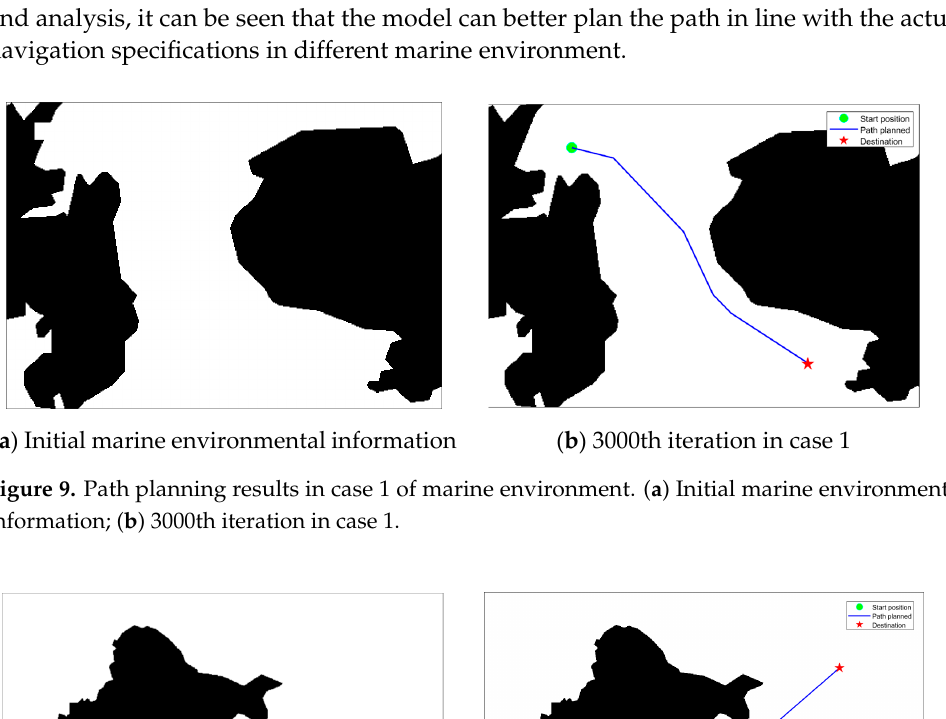
Figure 8. Path planning results under different iterations. ( a ) 500th iteration; ( b ) 1000th iteration; ( c ) 2000th iteration; ( d ) 3000th iteration. In order to verify the credibility and effectiveness of the model, this paper selects other complex marine environment for the experimental verification of ship path plan- ning. Figure 9 shows the path planning results of the model in marine environment case 1. Figure 9a shows the initial environment of marine environment case 1, and Figure 9b shows the path planning results after 3000 iterations. The starting point coordinates of the ship are (86, 265) and the target point coordinates are (326, 45). It can be seen from Figure 9b that the trajectory planned by the model avoids the obstacles and keeps a safe